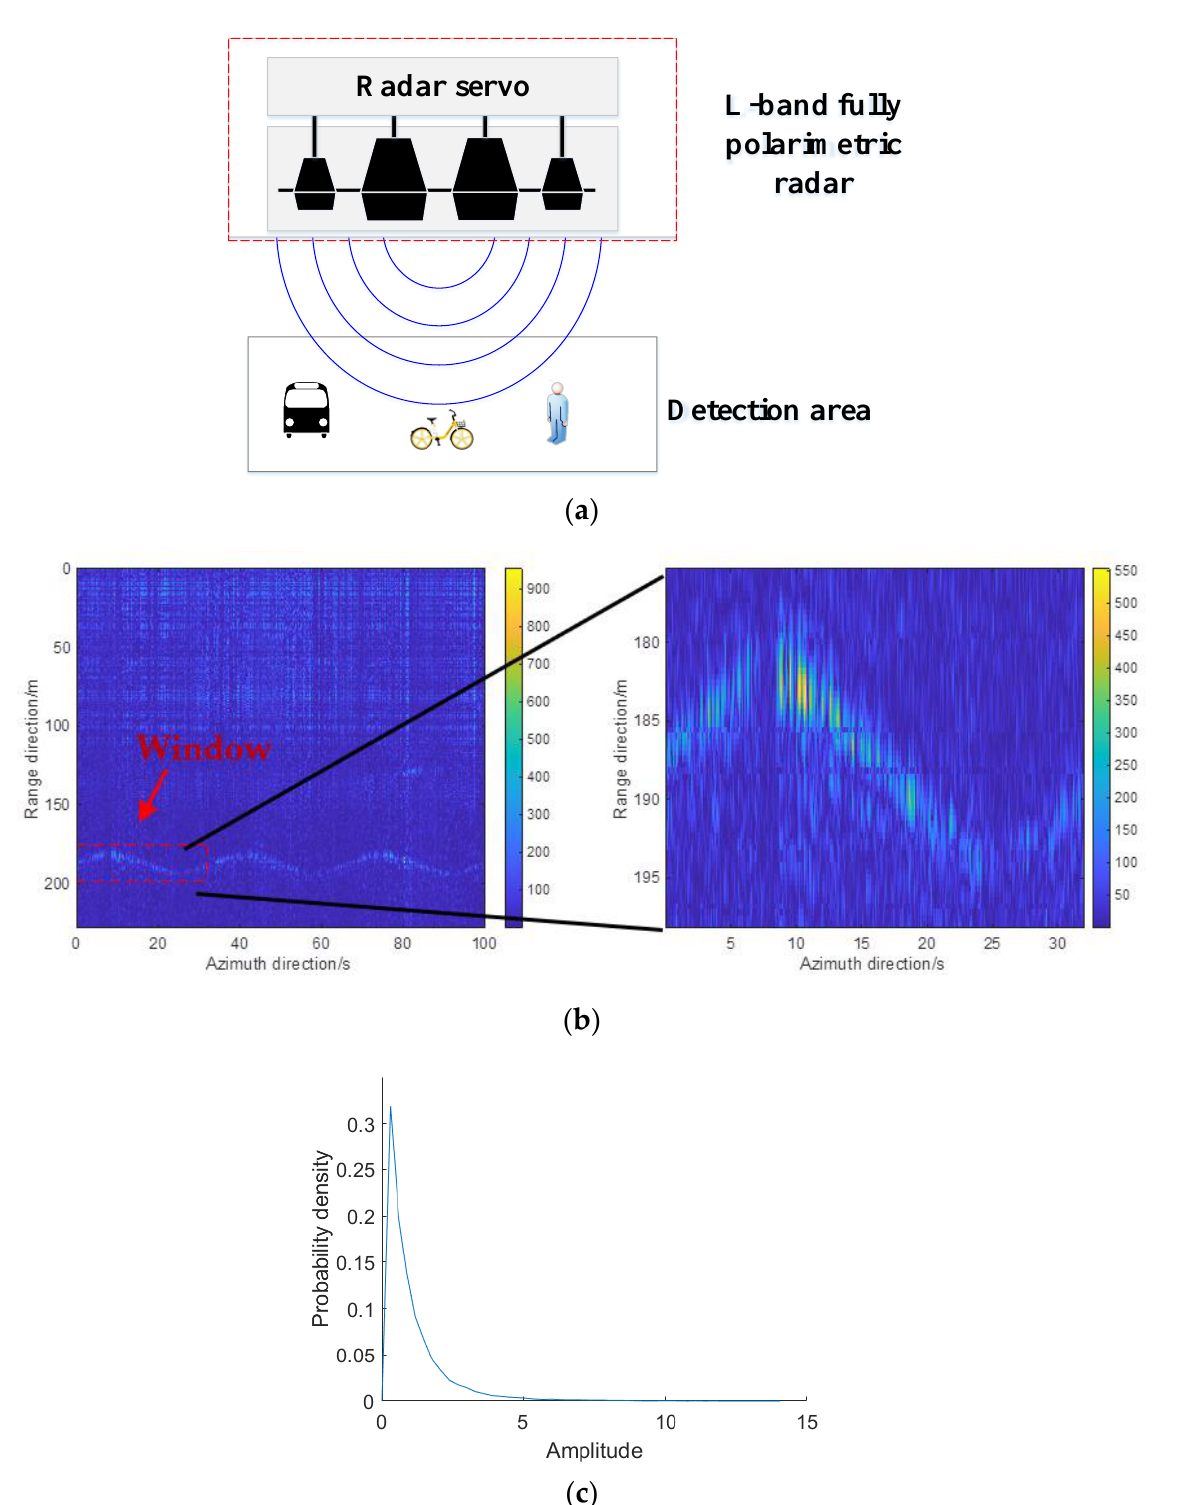
Figure 7. Estimation process of probability density function of radar echo. ( a ) Experiment scene. ( b ) 2D range compressed profile and its sampling window. ( c ) The curve of probability density func- tion.